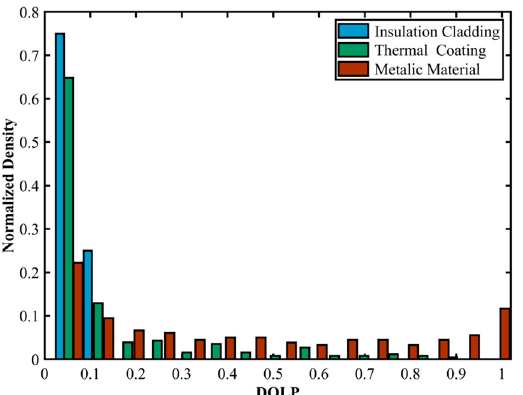
Figure 13. Probability density distribution characteristics of the degree of polarization for different space debris materials.